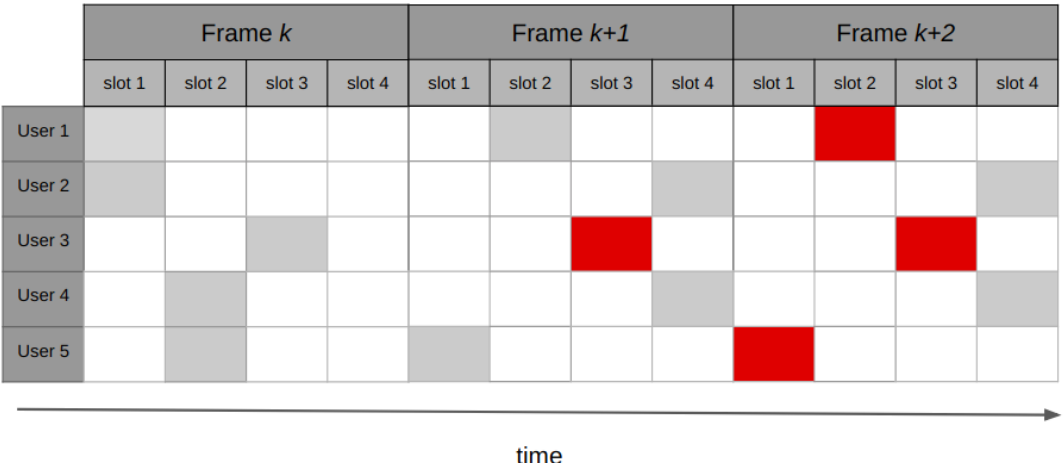
Figure 8. R-Aloha operation: five users contending for channel access. User three transmits successfully in slot three of frame k , and reserves the same slot in future frames k + 1 and k + 2. Users one and five achieve successful transmissions in frame k + 1, and place their reservations in frame k + 2 for slots two and one, respectively. Red packets correspond to active